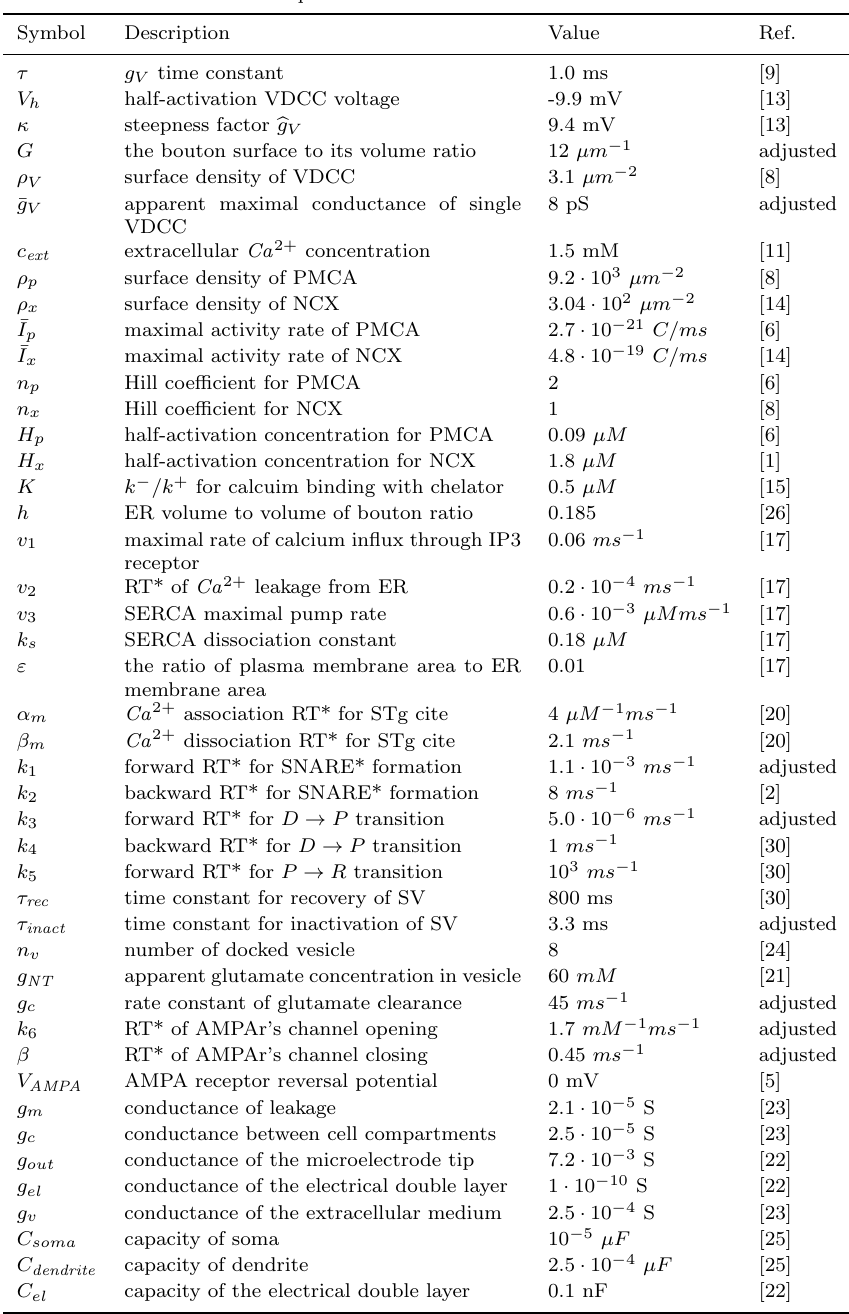
Table 2. The list of values of parameters involved in the model Symbol Description Value